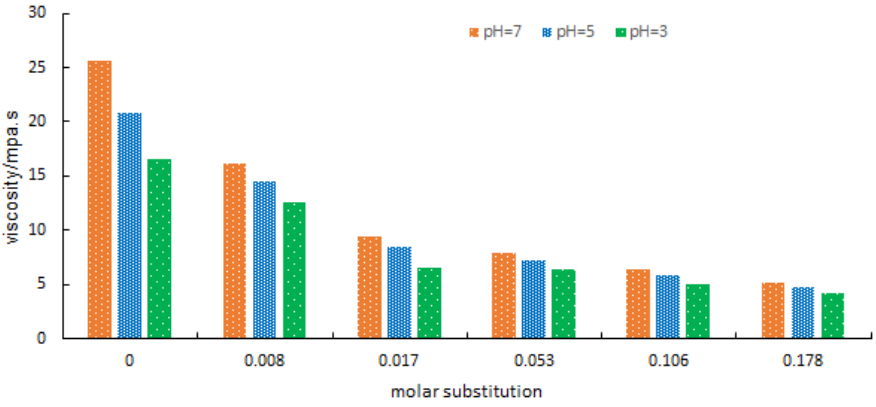
Figure 6. Effect of MS and pH on peak viscosity of native and γ -HPS.